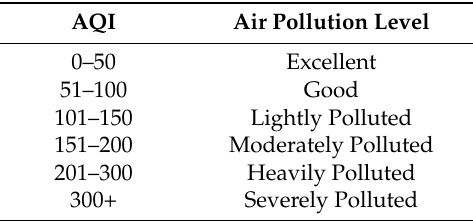
Table 1. AQI classification.